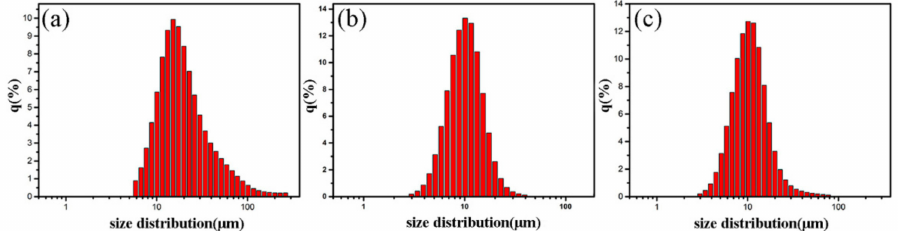
Figure 5. Particle size distributions of products with di ff erent contents of graphite exfoliated at di ff erent times: ( a ) 5 wt.% and 8 exfoliations, ( b ) 5 wt.% and 16 exfoliations, and ( c ) 8 wt.% and 16